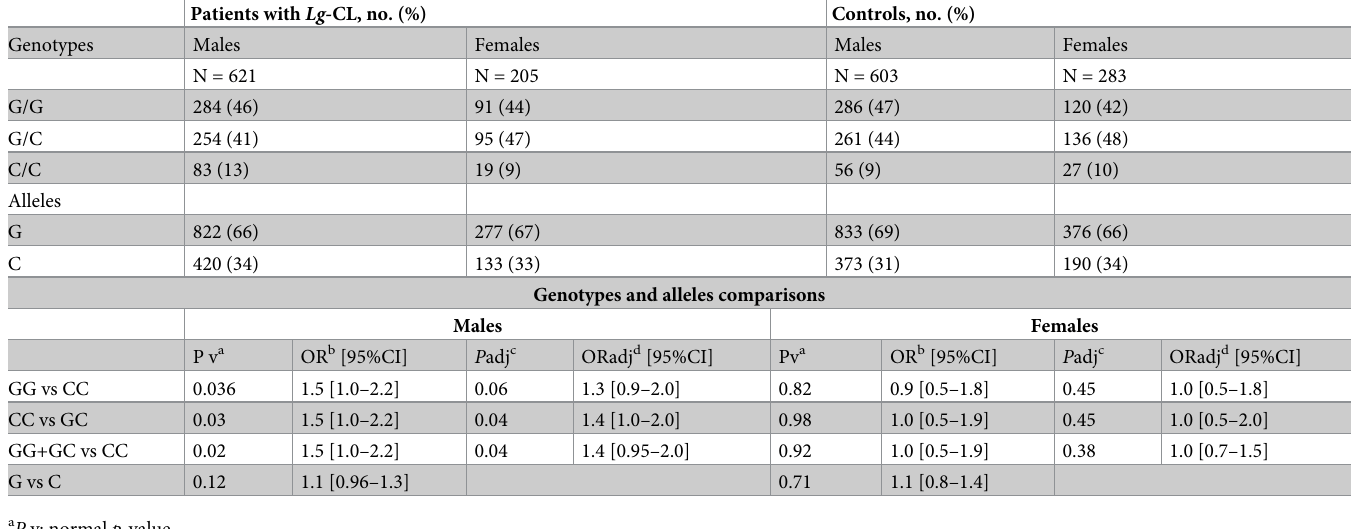
Table 2. Distribution and Comparison of Genotypes and Alleles frequencies of the MIR146A rs2910164 between Patients with Leishmania guyanensis -Cutaneous Leishmaniasis ( Lg -CL) and Controls stratified according to gender. Patients with Lg -CL, no.